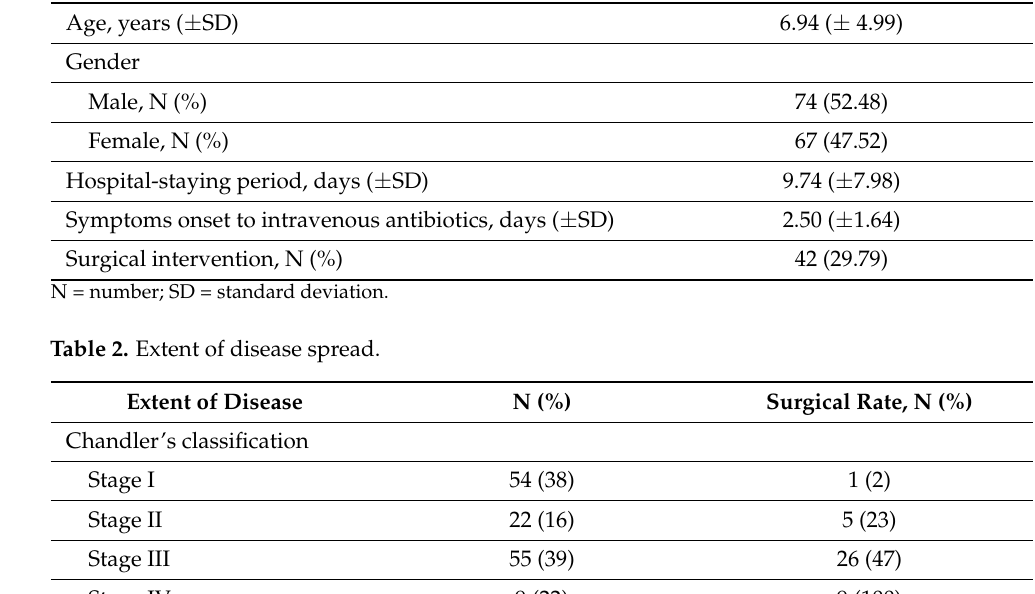
Table 1. Demographic and descriptive data of entire patient cohort.